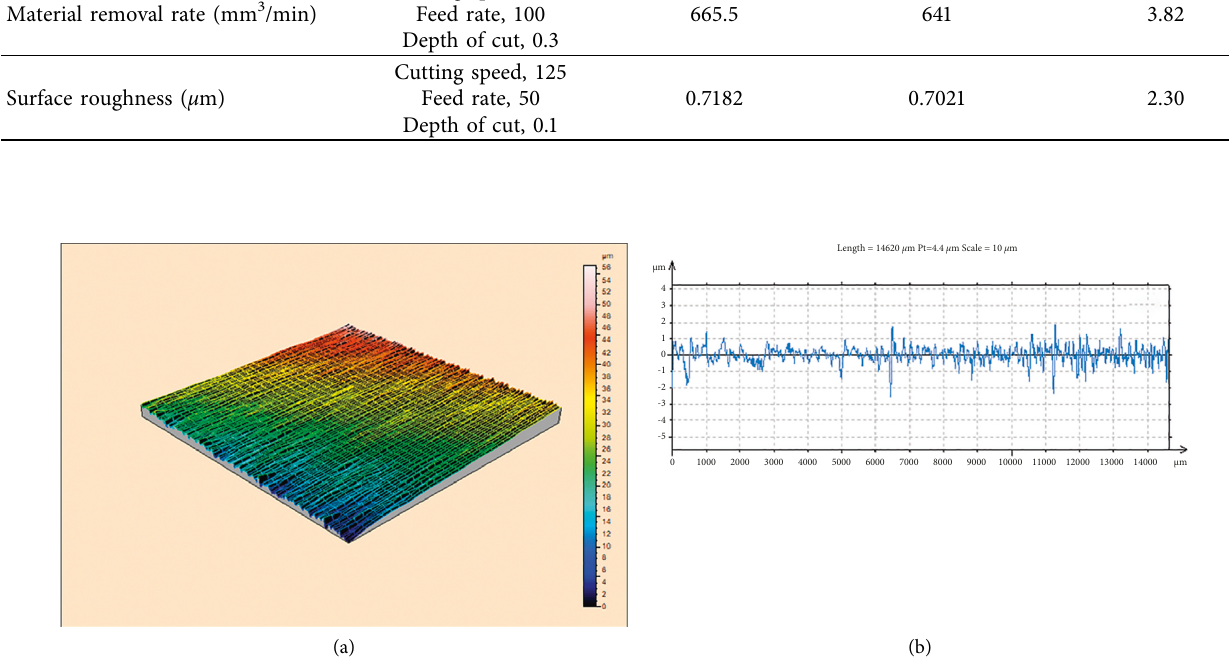
Figure 9: 3D surface roughness plot for the optimized machining condition.